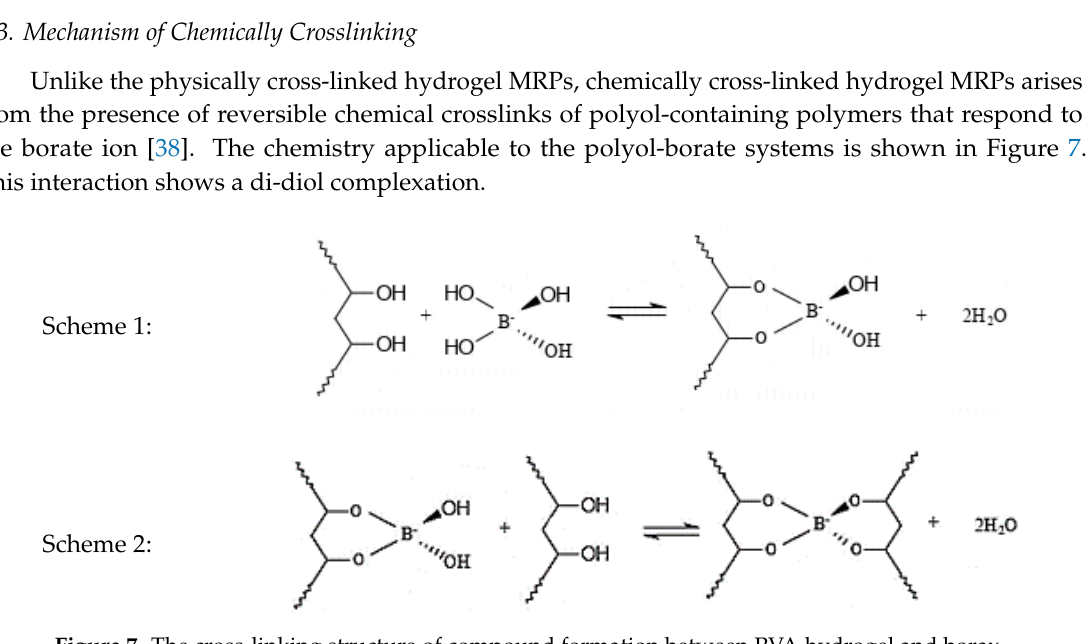
Figure 7. The cross-linking structure of compound formation between PVA hydrogel and borax.